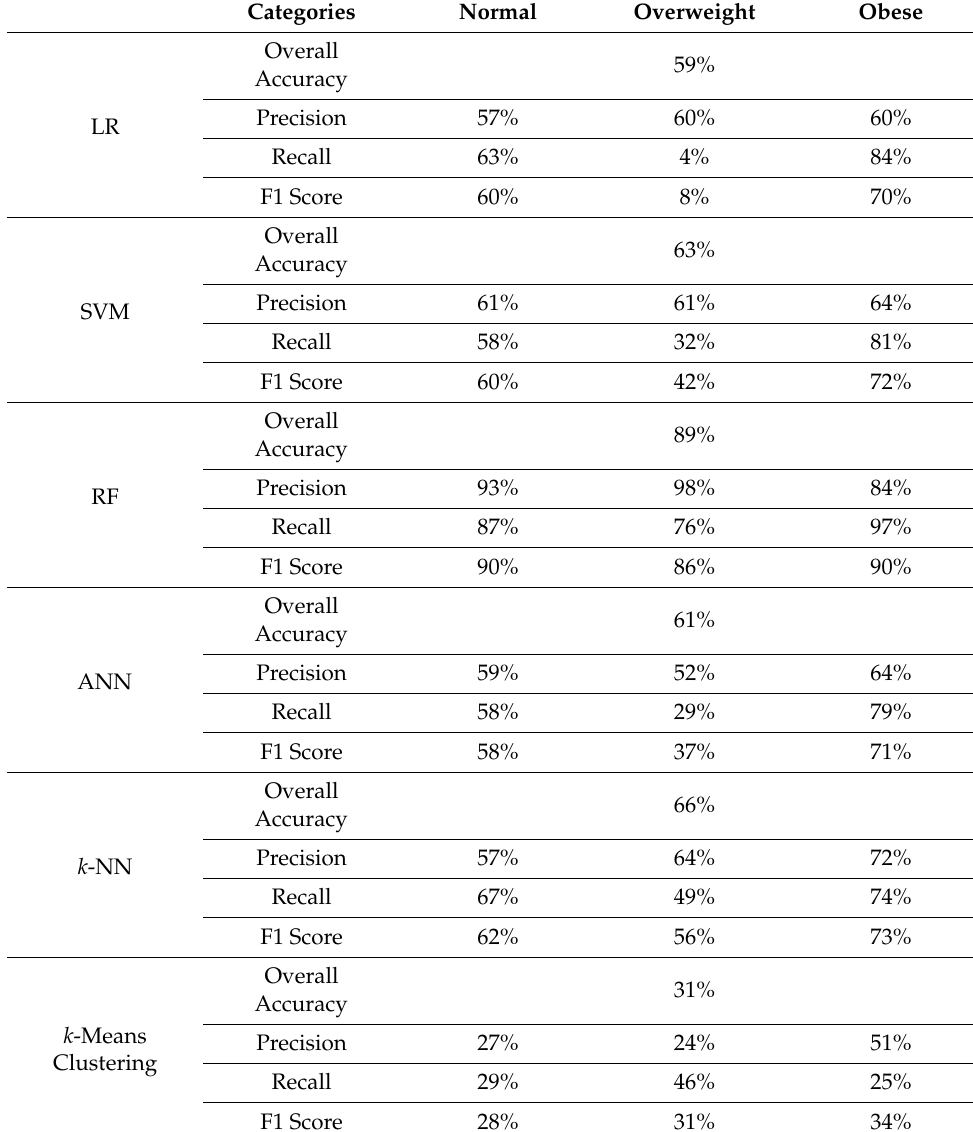
Table 9. Evaluation of performance for obesity prediction based on multiple random visits on an unbalanced